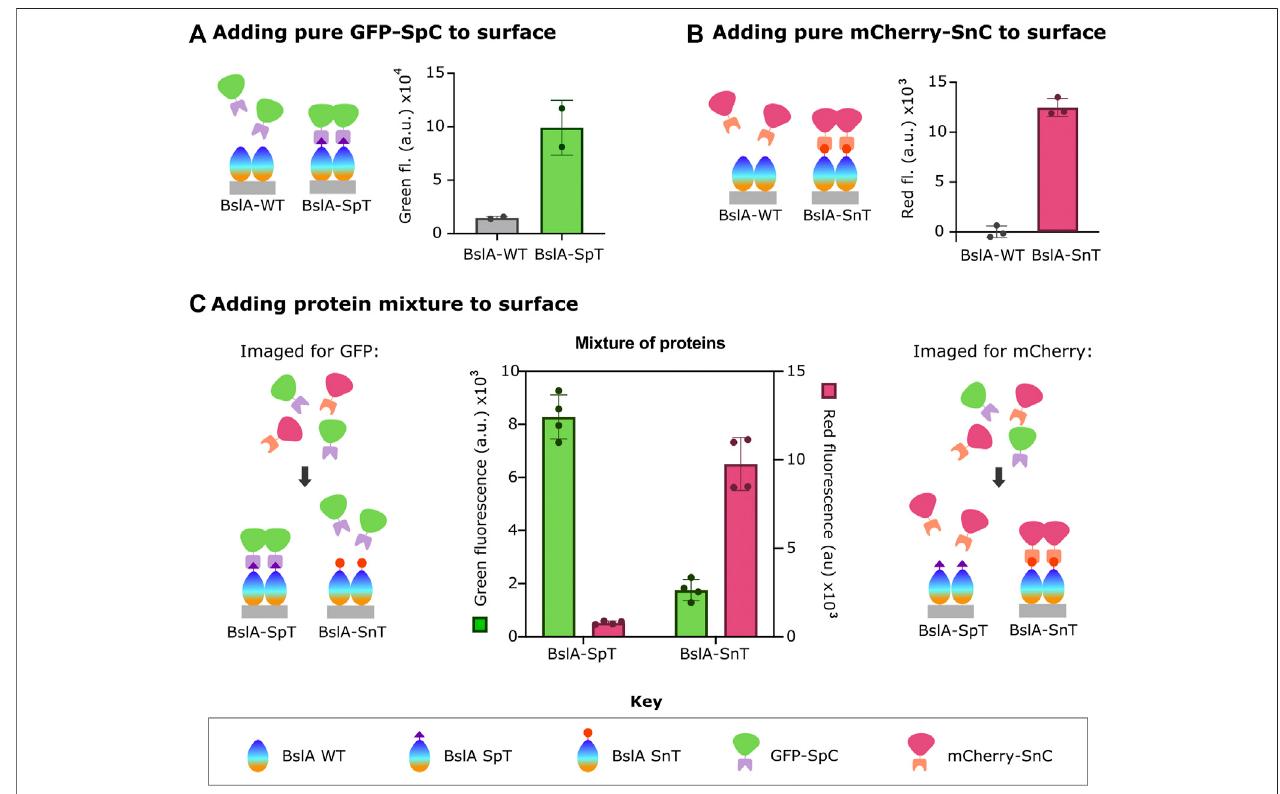
FIGURE1| SurfacesformedbyBslA-SpTorBslA-SnTcaptureFPfusedtoSpCorSnC,respectively.Thekeyatthebottomofthe fi gureindicatestheidentityofthe protein components in thecartoons. In A-C,thecartoons leftillustratethe experiment in schematic form, withthecorrespondingdata shown nexttoit.Puri fi ed (A) GFP- SpC or (B) mCherry-SnC proteins were incubated with BslA-WT, BslA-SpT or BslA-SnT surfaces. Fluorescence remaining in each well was measured after removal of non-boundproteinandwashingofthewells.In (C) ,asimilarprotocolwasfollowed,butheremixturesofGFP-SpCandmCherry-SnCwereincubated(atequimolar concentration) with either BslA-SpT or BslA-SnT surfaces. Measured green fl uorescence of either the BslA-SpT or BslA-SnT coated wells are shown with the green coloured bars, corresponding to the left y -axis. Measured red fl uorescence of the wells is shown with the pink coloured bars, with values corresponding to the right y -axis. In all cases, the fl uorescence of a well with BslA and buffer was subtracted as the blank. Original data is available in the Supplementary Data Sheet . Error bars show standard deviation.